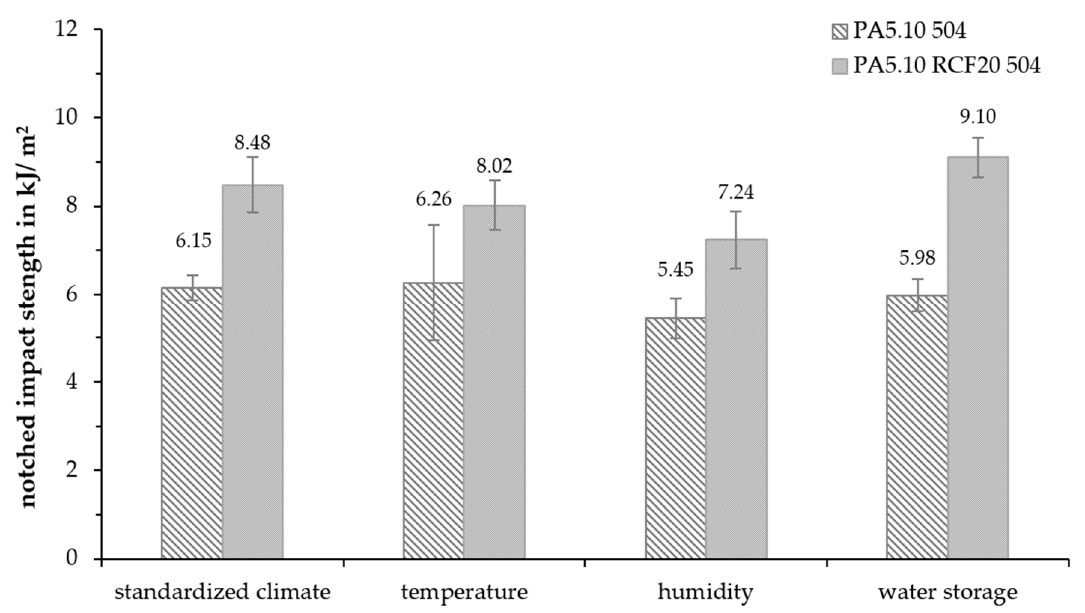
Figure 13. Notched impact strength of the accelerated-aged test specimens after 504 h.